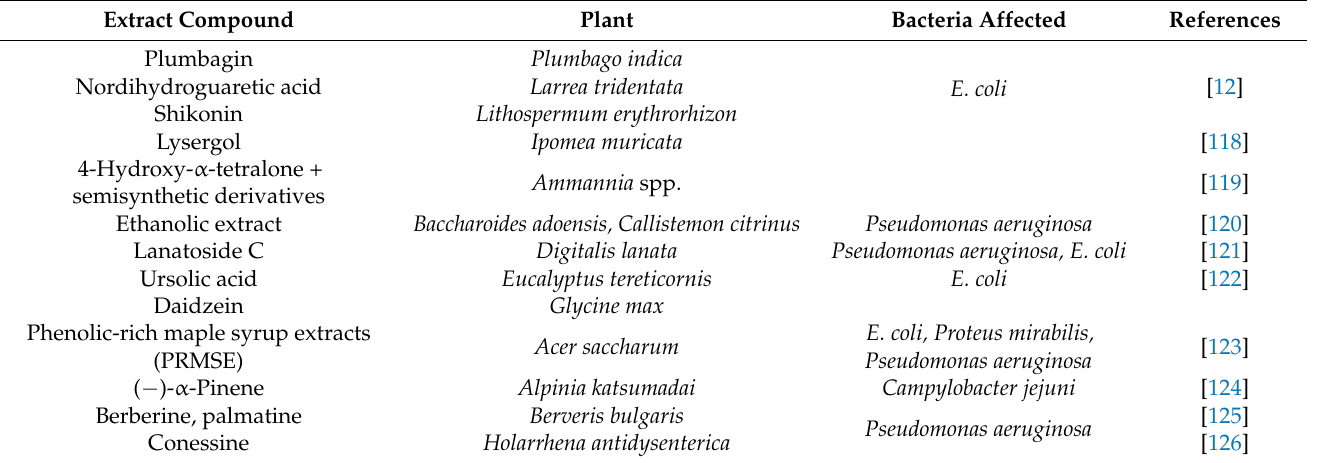
Table 2. Examples of EPIs from plants with inhibitory activity against Gram-negative bacteria efflux pumps.